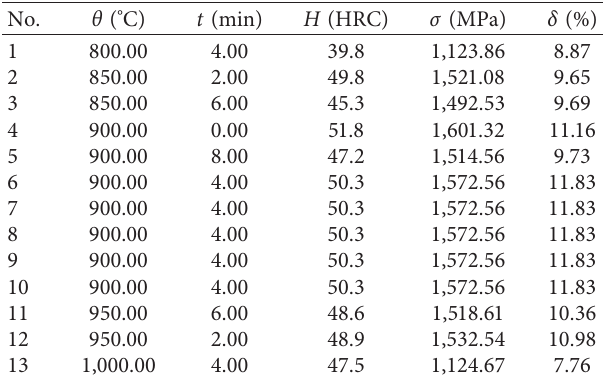
Table 3: Experimental results.